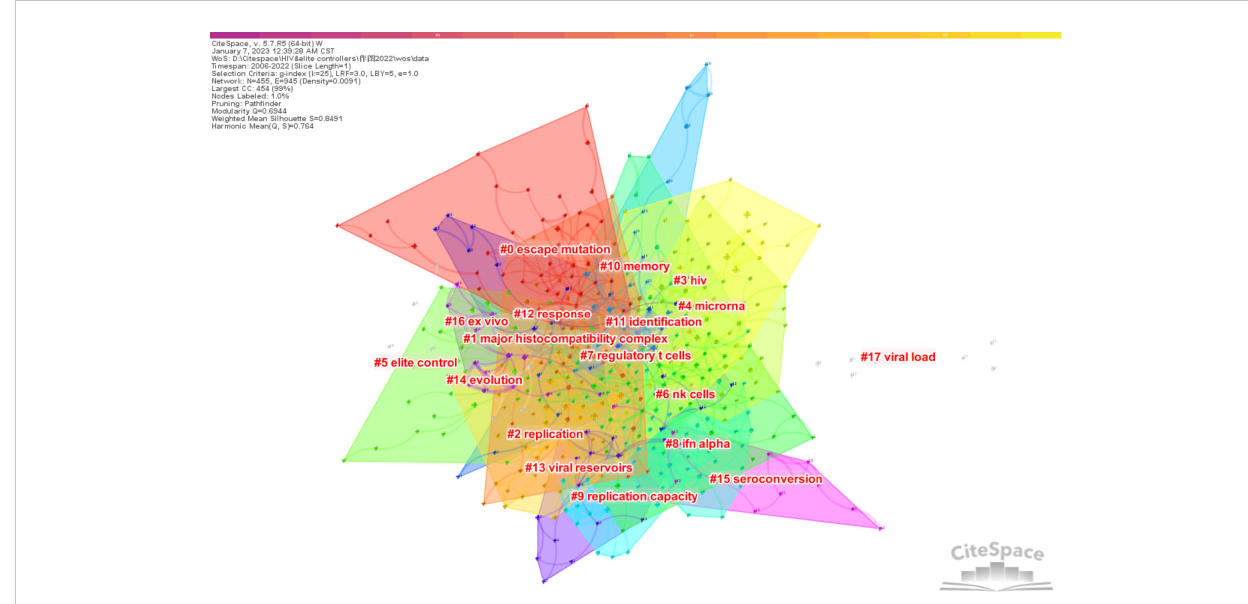
FIGURE 9 Clustered networks based on cooccurrence status of the keywords via CiteSpace. Red words are cluster labels extracted by LLR